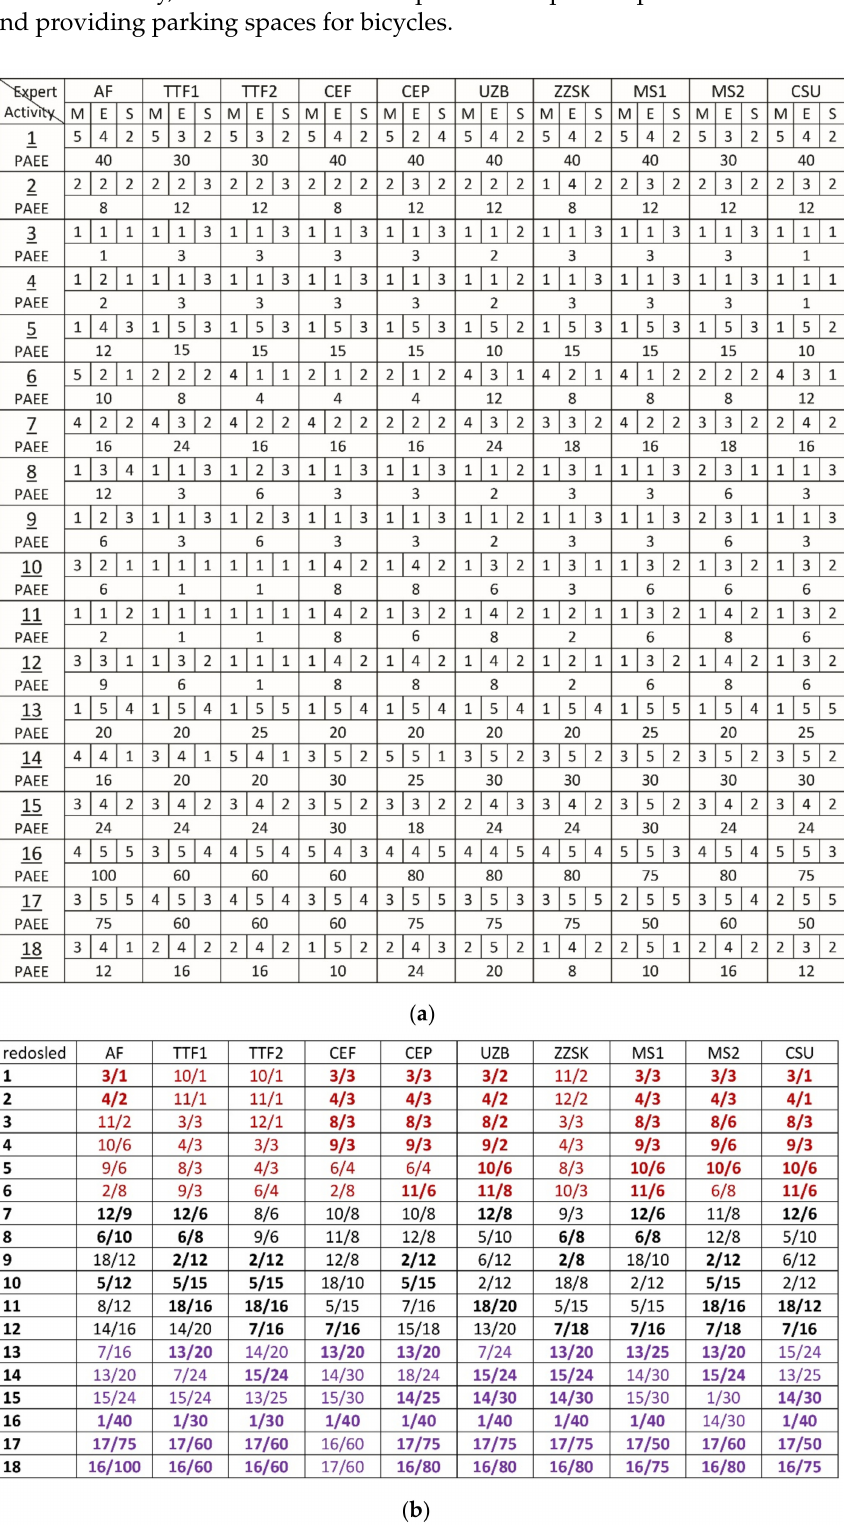
Figure 3. ( a ) FIRST STEP—Elaborating the consequences of activities. ( b ) SECOND STEP—Hierarchy of activities with corresponding Priority Activity for Energy Efficiency” (PAEE)